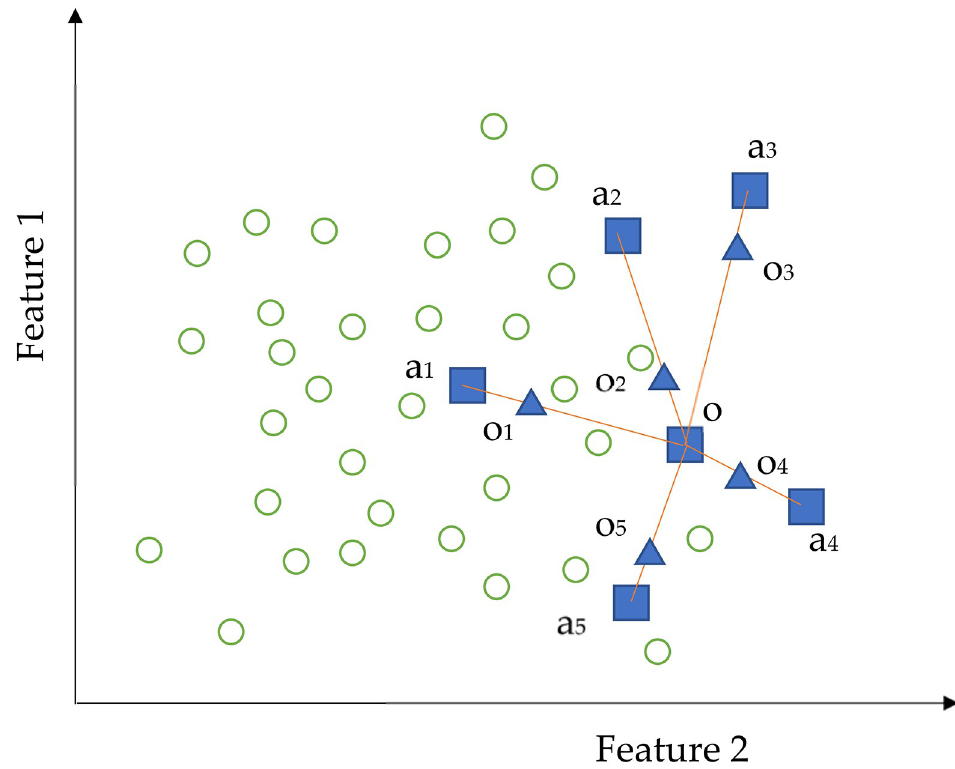
Fig 6. SMOTE algorithm: The blue square and green circle represent the minority and majority classes, respectively. The KNN of point O in the minority set was obtained by calculating the Euclidean distance between O and each sample in the set. Based on the k (k = 5), the algorithm connected the k (k = 5) minority points (a1, a2, a3, a4, a5) around O, and finally inserted new synthetic points (O1, O2, O3, O4, O5) on the line of the two points, until the number of all the minority types and insertion points was balanced with the number of majority